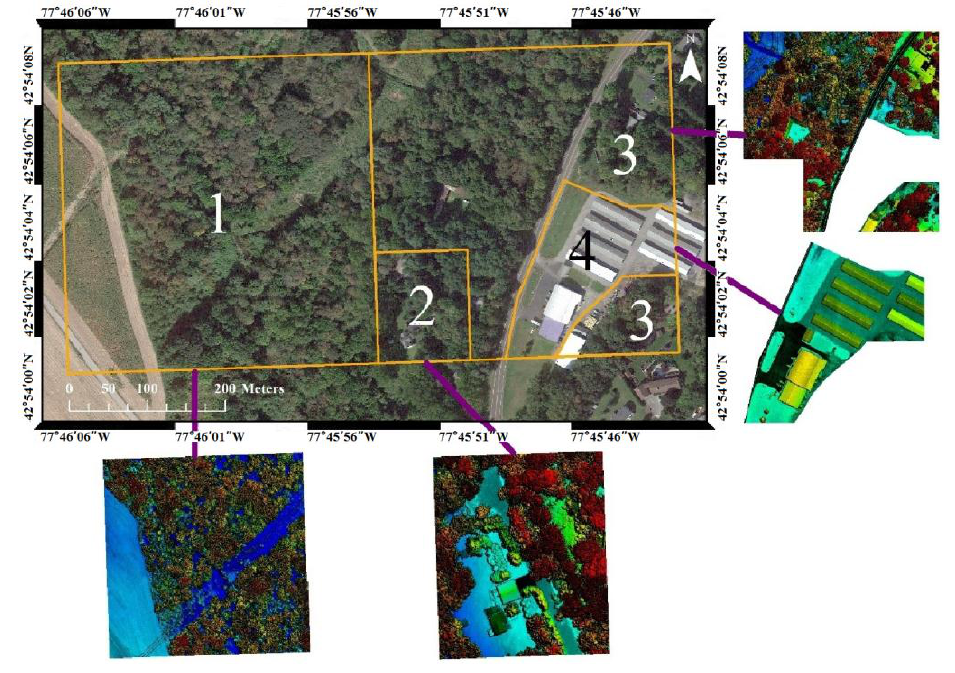
Figure 4. Sub-area division